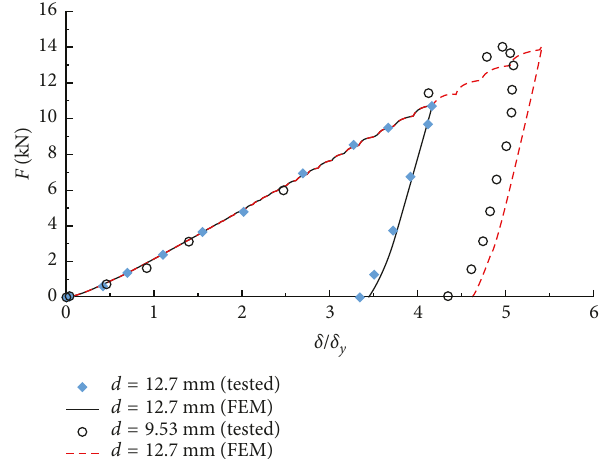
Figure 6: Normal force-displacement curves for dimer stainless steel